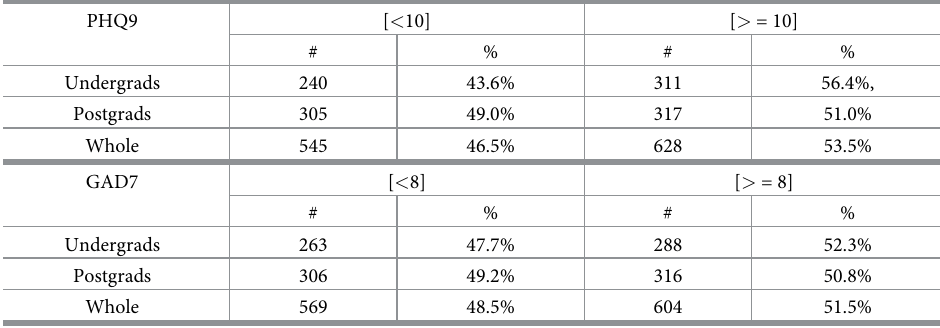
Table 12. Distributions of PHQ9 and GAD7 based on clinical thresholds and education